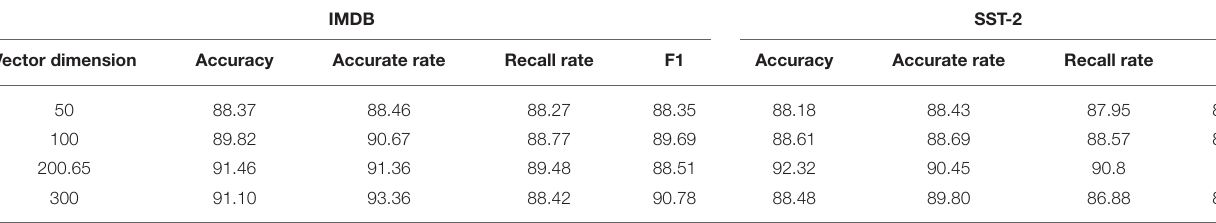
TABLE 3 | Experimental results of the different vector dimensions of words.